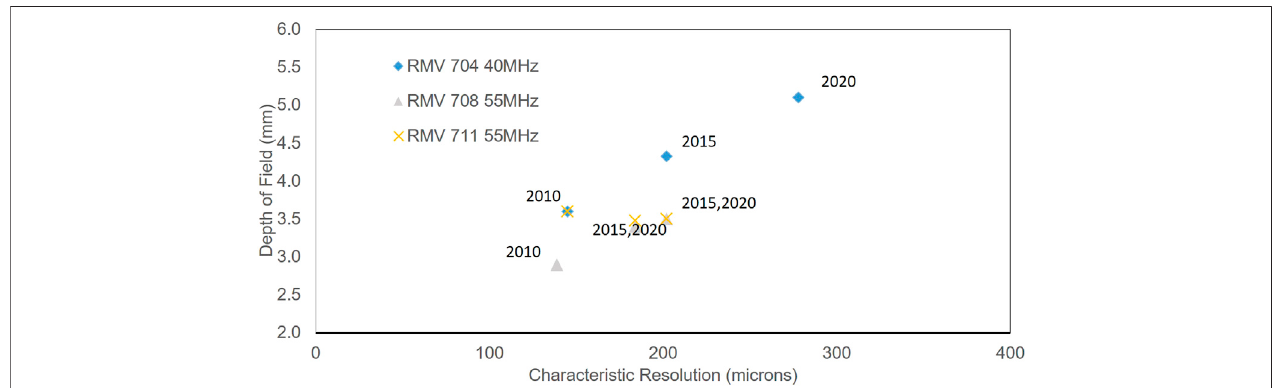
FIGURE 3 | Measured values of depth of fi eld and characteristic resolution for three single element preclinical transducers. Data shows results of measurements undertaken in 2010, 2015 and